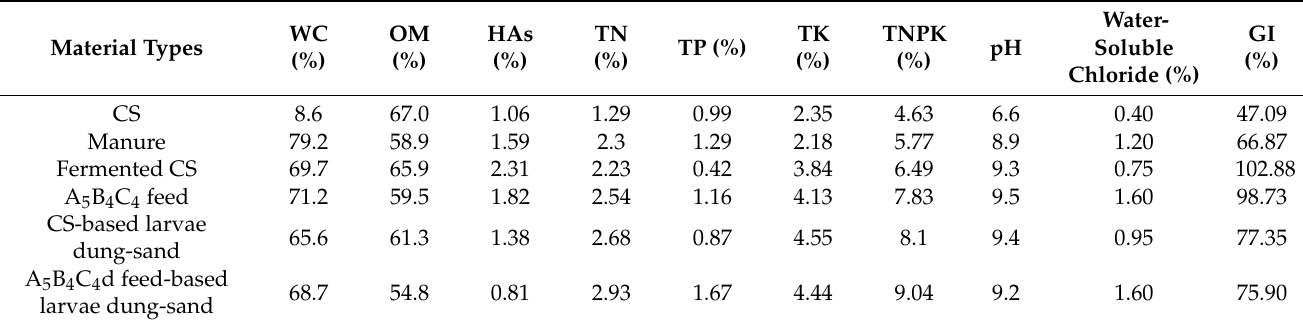
Table 9. Main nutritional indicators for raw materials, fermentation materials, and larvae dung-sand as organic